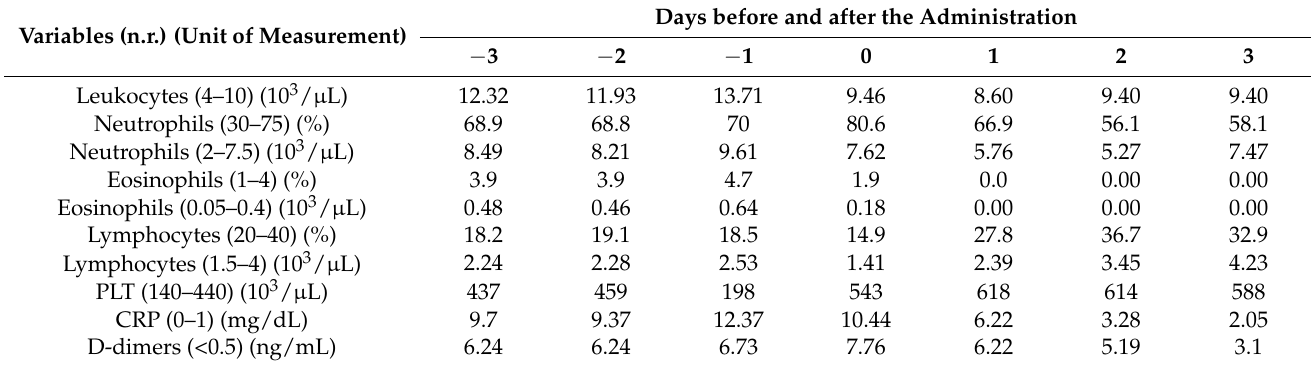
Figure 2. Vasculitic lesions on upper and lower limbs, with a tendency for generalization. Table 1. Laboratory parameters before and after administration of Benralizumab.